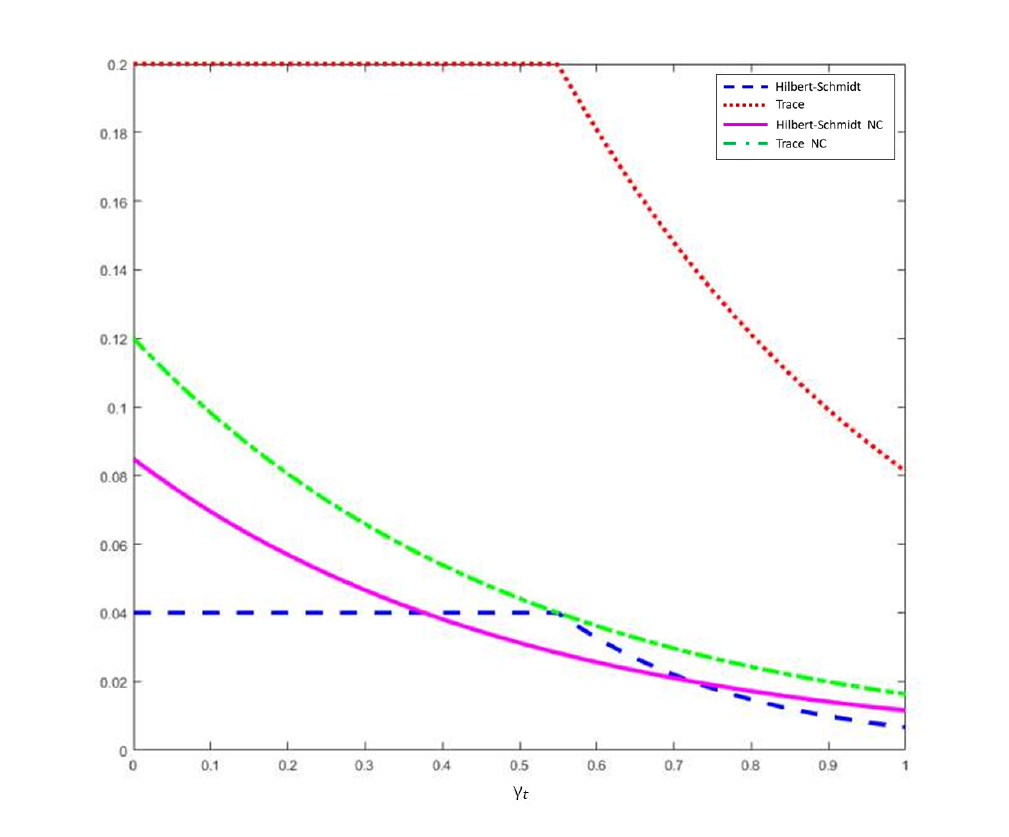
Figure 1. A two-qubit system under the operation of Dephasing channel where c 1 ( 0 ) = 0.6, c 2 ( 0 ) = 0, c 3 ( 0 ) = 0.2, and NC means